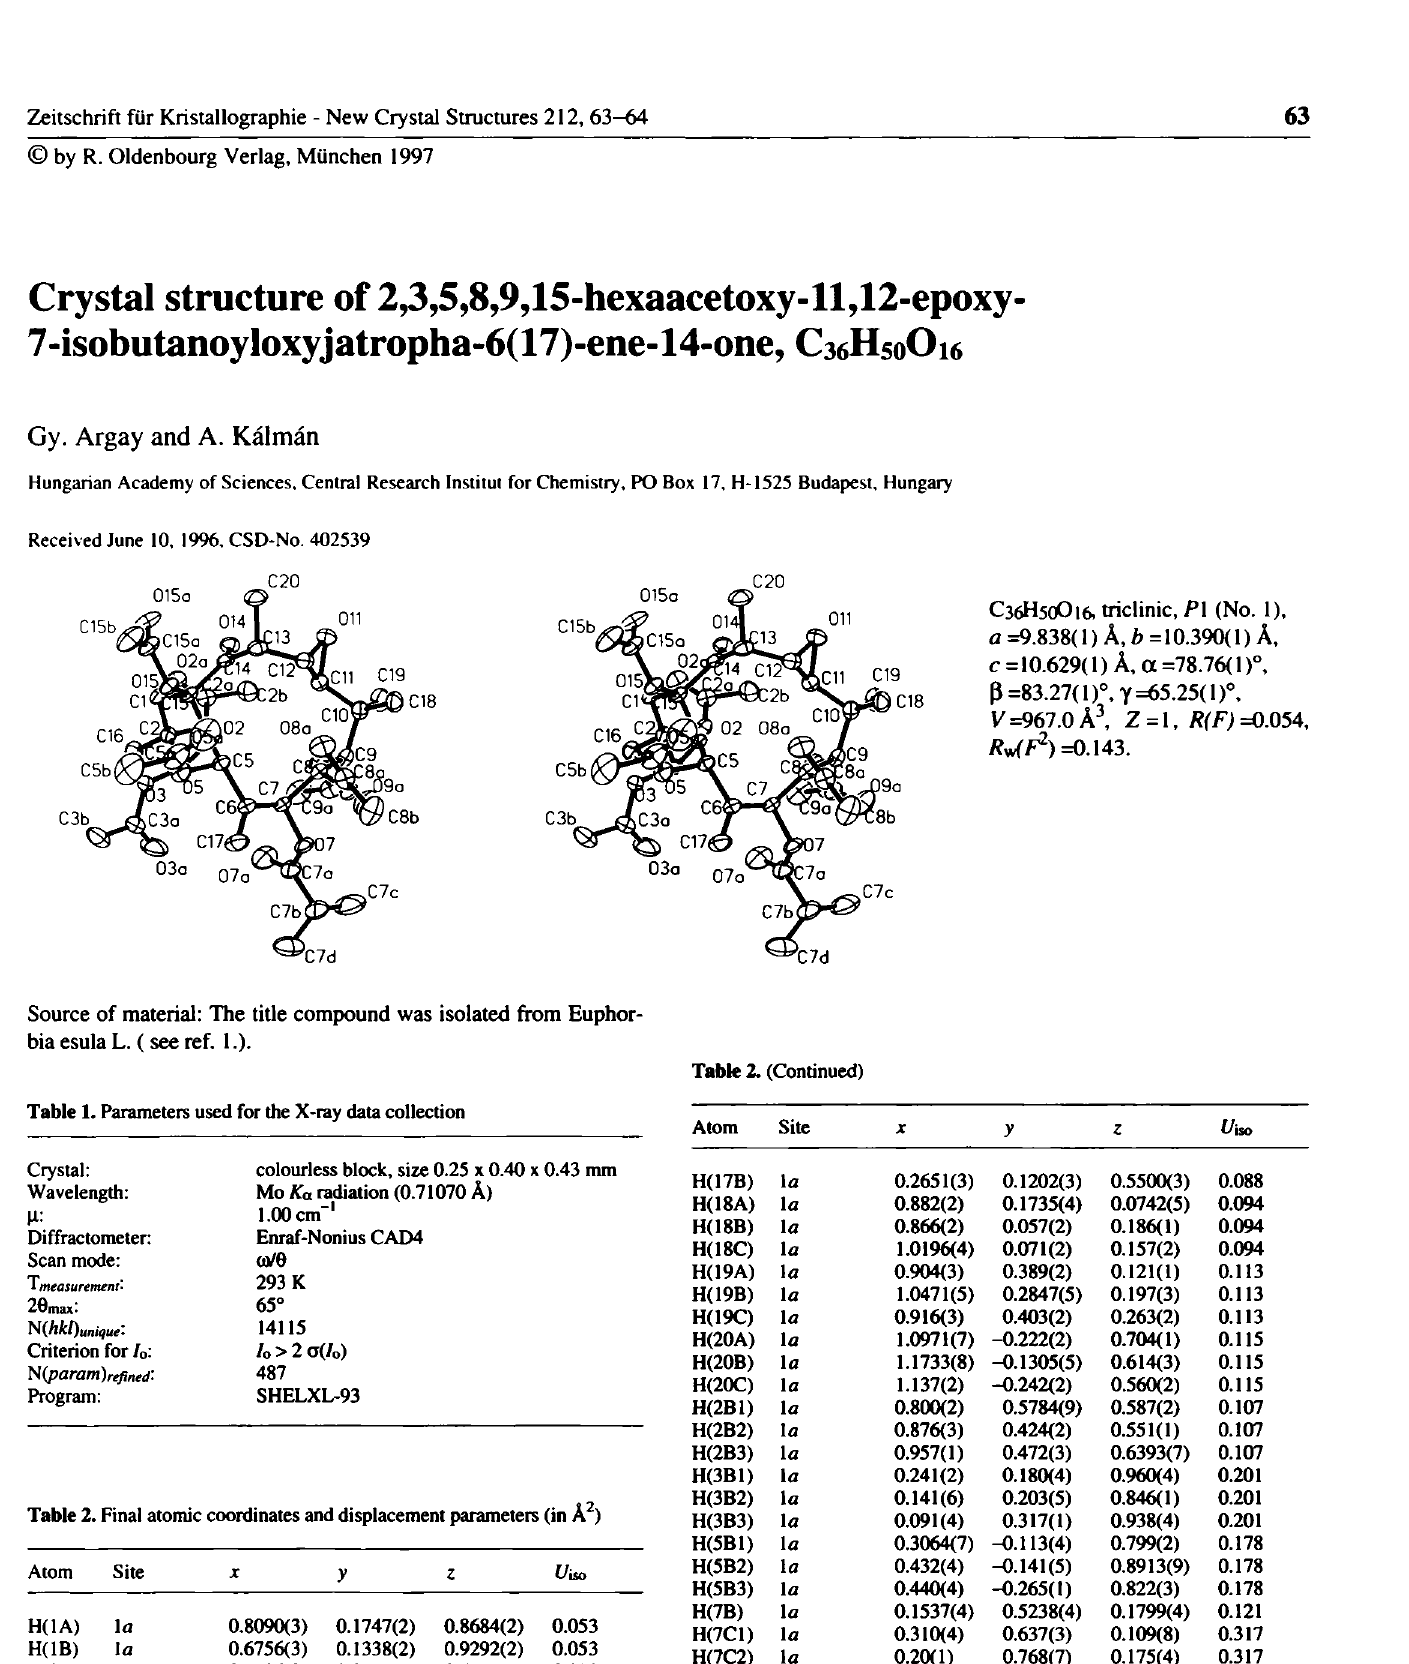
Table 2. Final atomic coordinates and displacement parameters (in Â 2